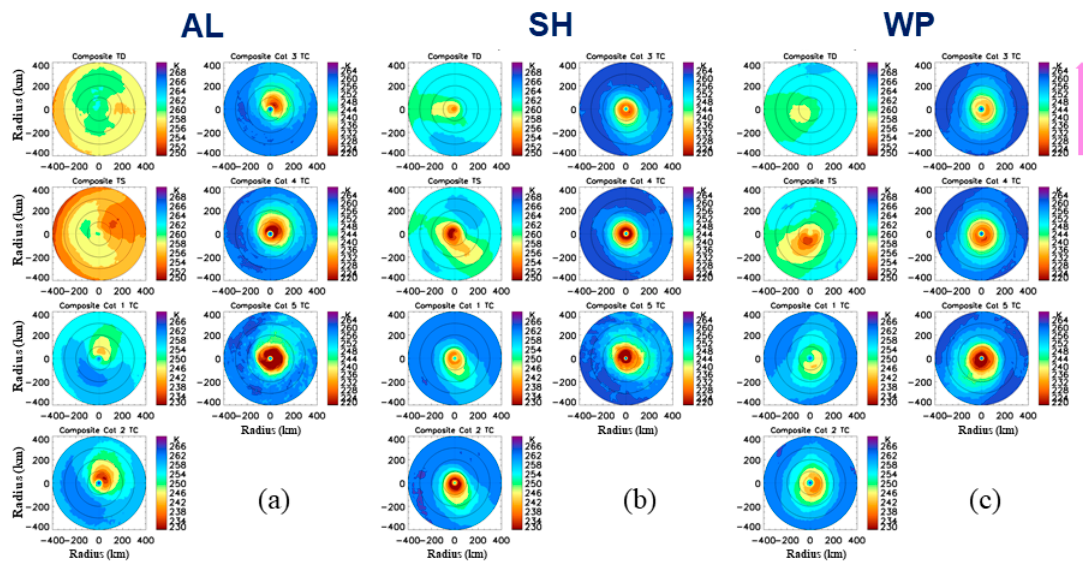
Figure 10. Same as Figure 7, except for relative to the North direction.